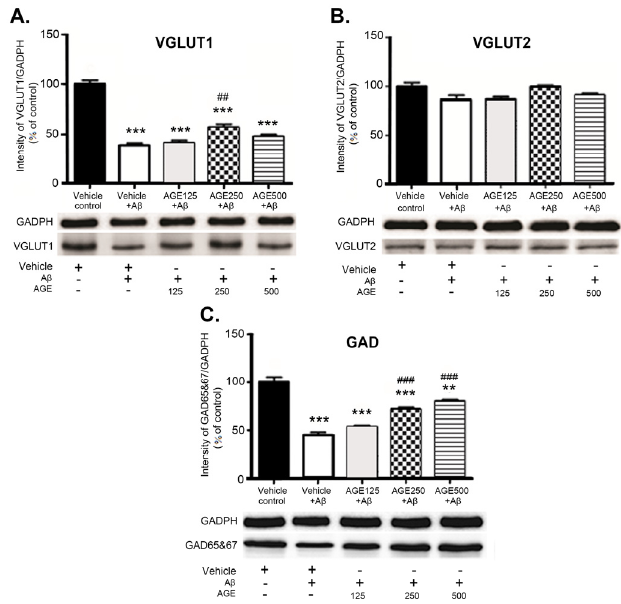
Figure 5. Effects of AGE on amounts of VGLUT1 ( A ), VGLUT2 ( B ) and GAD 65 and 67 ( C ) in the rat hippocampus. Data are presented as mean ± S.E.M ( n = 8), **, *** = significant differences from the vehicle control group at p < 0.01 and 0.001 respectively ## , ### = significant differences from the vehicle + A β group at p < 0.01 and 0.001, respectively. VGLUT1 and VGLUT2, vesicular glutamate transporter 1 and 2 proteins; GAD, glutamate decarboxylase.